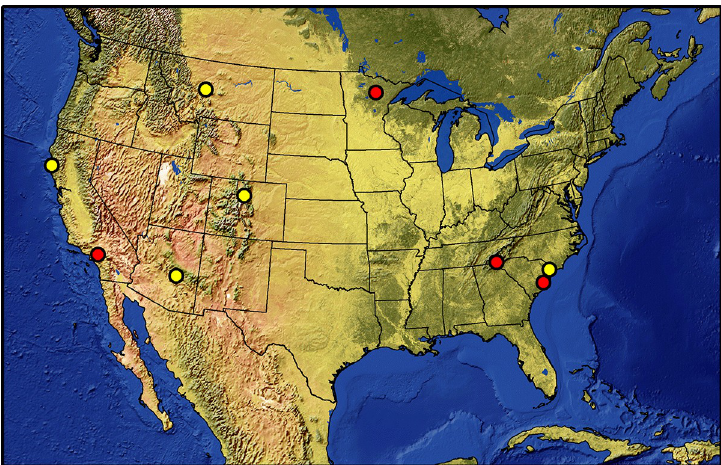
Fig 1. Nine FACE wood decomposition experiment study sites in the continental USA used for model calibration and validation; red spots are the sites for model calibration, and yellow for the validation; this figure was produced with the data from Natural Earth. Free vector and raster map data @ naturalearthdata.com.